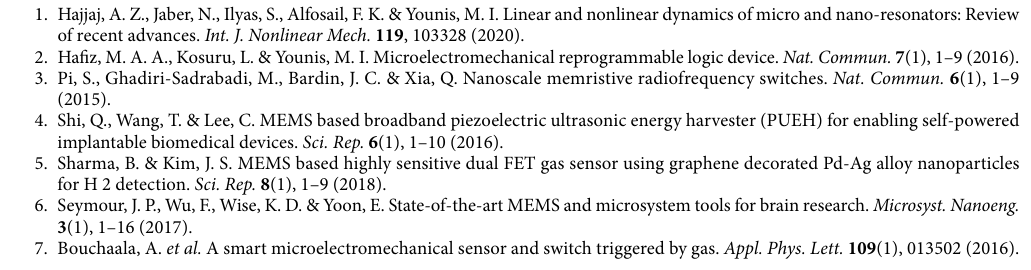
Figure 8c–e show the frequency responses of the 1st and 2nd modes of L1, L2, and L3 lines highlighted in Fig. 8a,b. In line L1, where the ratio is higher than ω 2 /ω 1 > 2, the saturation phenomenon occurs when the struc- ture is excited around twice ω 1 , and the nonlinear softening behavior is observed from the outcome of the 1st mode. The phenomenon is also realized when the ratio is smaller than 2:1, as shown by the frequency response of line L3. On the other hand, hardening behavior is noted from the response of the 1st mode. Although the resonance frequencies of the 2nd mode at lines L1 (ω 2 = 157.6 kHz) and L3 (ω 2 = 148.1 kHz) are far from the exact 2:1 ratio (ω 2 = 154.3 kHz), the saturation phenomenon is still achievable. When the ratio is very close to 2:1, the classical “V-shape” curve of the saturation phenomenon is observed either for the 1st or 2nd mode, as shown in the response of line L2. In addition, it is important to highlight that the saturation phenomenon dominates the response over any other nonlinearity. This is observed in Figs. 6 and 8d, as the phenomenon is presented dominant over the nonlinear softening behavior induced by the electrostatic force. For a more comprehensive overview, Fig. S3 in the Supplementary Material shows the numerically simulated responses of Fig. 8. In addition, Fig. S3b highlights the shift of the nonlinear softening behavior along with the tune of the DC load. The numerical simulations show a qualitative agreement with the experimental results, demonstrating that the mathematical model can support further researches on the MEMS/NEMS U-shape portal